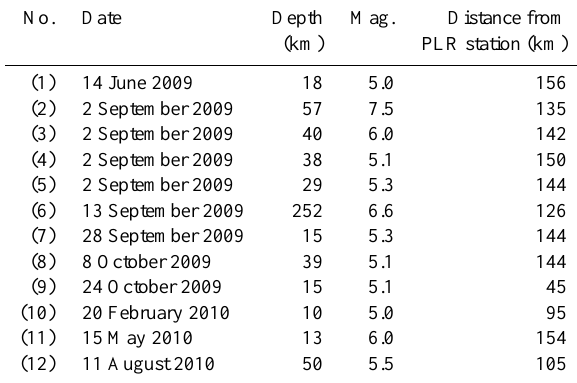
Table 1. List of EQs analyzed in this study.